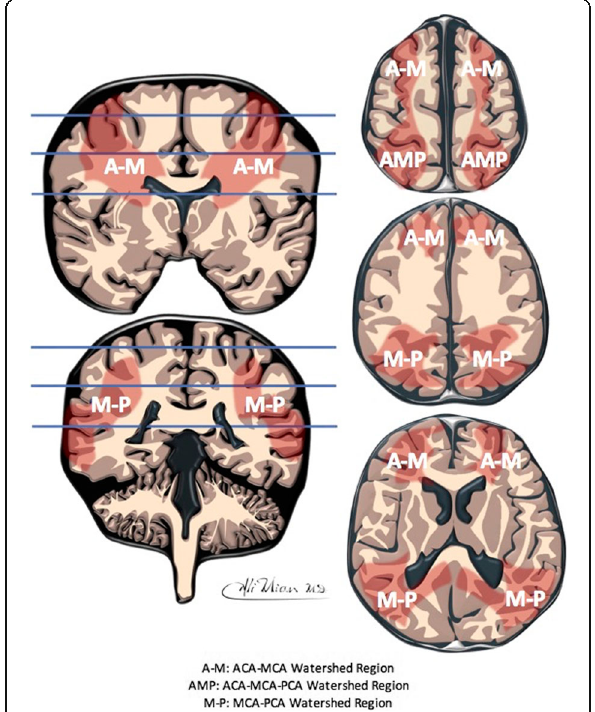
Fig. 1 Schematic representation of the inter-arterial watershed regions (depicted in red overlay). The horizontal lines on the coronal images (on the left) depict the levels at which the axial images (on the right) are derived from. The letter annotations depict the confluence between anterior cerebral artery (A = ACA) and middle cerebral artery (M = MCA); ACA, MCA and posterior cerebral artery (P = PCA); and between MCA and